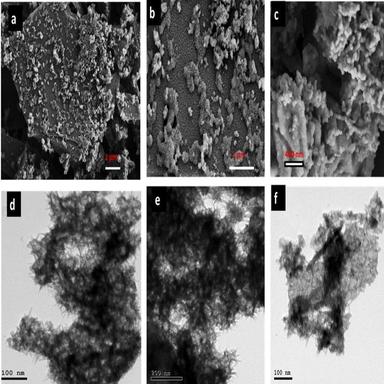
(a, b, c) SEM and (d, e, f) TEM results of the nZVI@ACh composite.